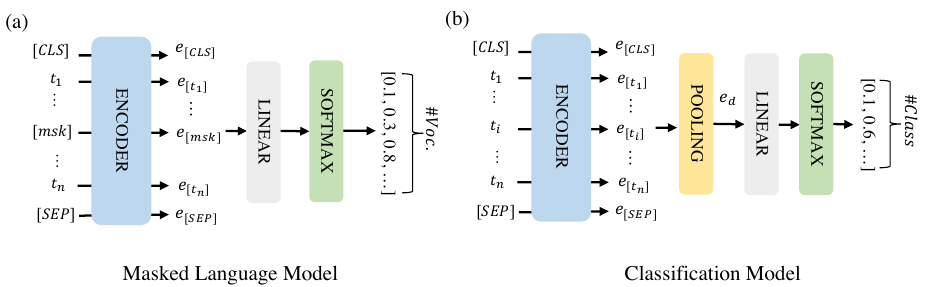
Figure 1. The model architectures for MLM ( a ) and classification ( b ). [CLS] and [SEP] are two special tokens indicating the start and end of the text sequence and [msk] are masked